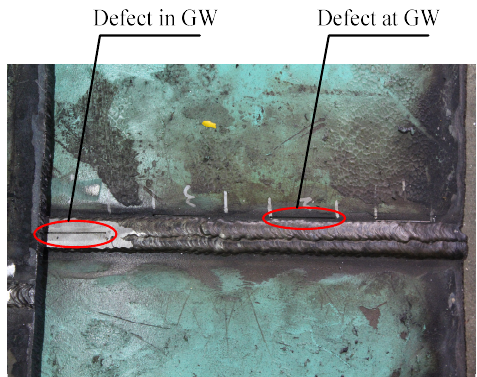
Figure 2. Set of test notches with different depths and lengths.